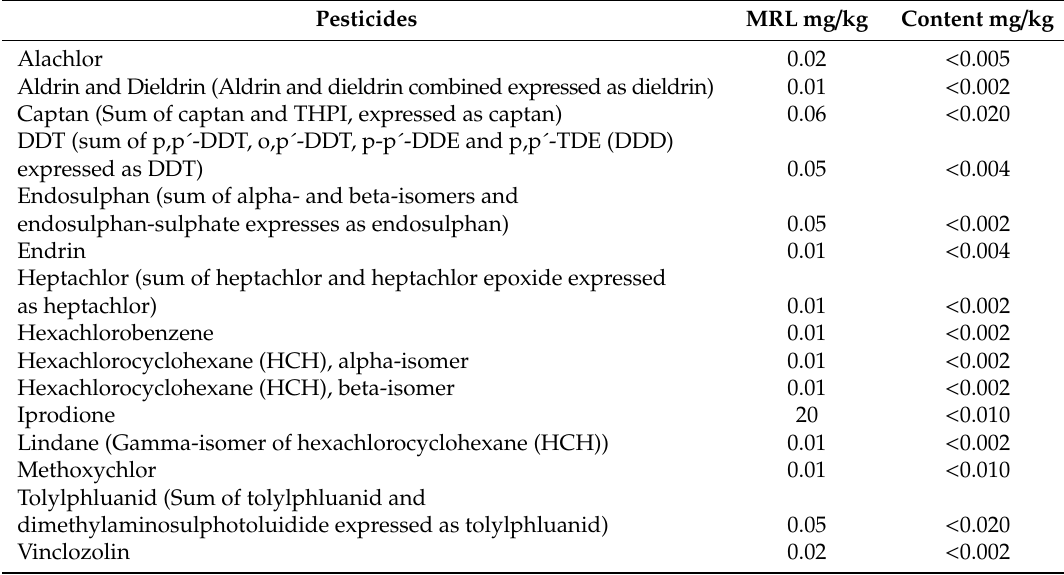
Table 9. Residue levels and maximum residue levels (MRLs) of pesticides (mg / kg) in olive leaves (OLs) samples.